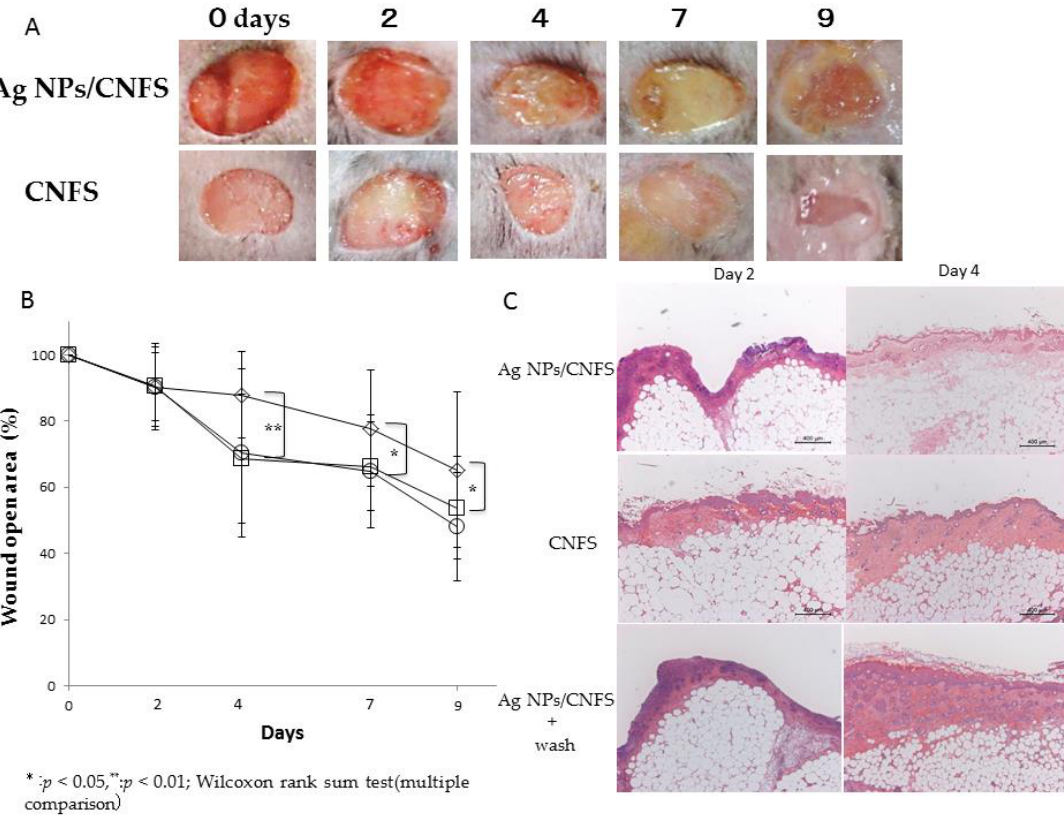
Figure 4. Effects of Ag NPs/CNFS removal and washing on wound epithelialization. Ag NPs/CNFS